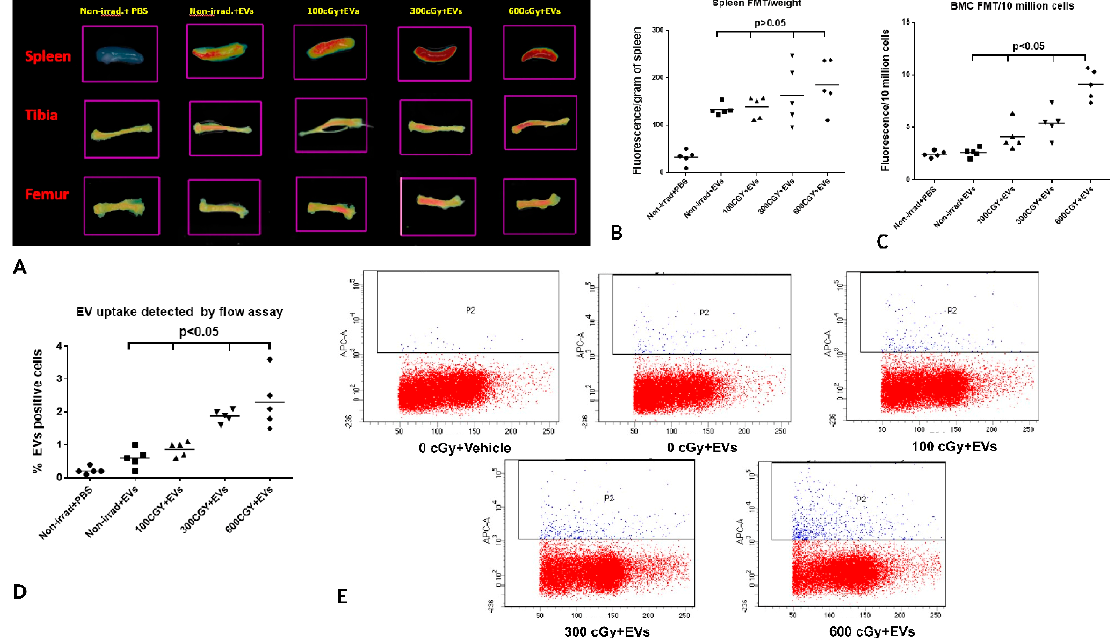
Figure 5. EV biodistribution in spleens, tibias, and femurs. ( A ) Representative images of a spleen and tibia and femur bone marrow from mice with 0 or 100, 300, and 600cGy radiation exposure at 6 h after DiD-EVs injection. n = 5 mice / group. ( B ) DiD-labeled-EV accumulation in the spleen. ( C ) Quantification of DiD-labeled EVs within bone marrow. ( B,C ) The intensity of fluorescence was expressed as the average of fluorescence intensity (count / energy) / weight of tissue or 10 million bone marrow cells ± SEM. The fluorescence intensity in bone marrow from EV treated animals with or without radiation were analyzed by ANOVA. A P value ≤ 0.05 was considered statistically significant ( D ) Uptake of human MSC-EVs by Murine bone marrow cells. After FMT analysis, the bone marrow cells were flushed from one tibia and one femur, and DiD positive bone marrow cells were detected by flow cytometry. The percentage of DiD-positive BMCs from EV treated animals with or without radiation was analyzed by ANOVA. A P value ≤ 0.05 was considered statistically significant ( E ) Representative flow cytometric analysis of MSC-EV uptake by Murine bone marrow cells.